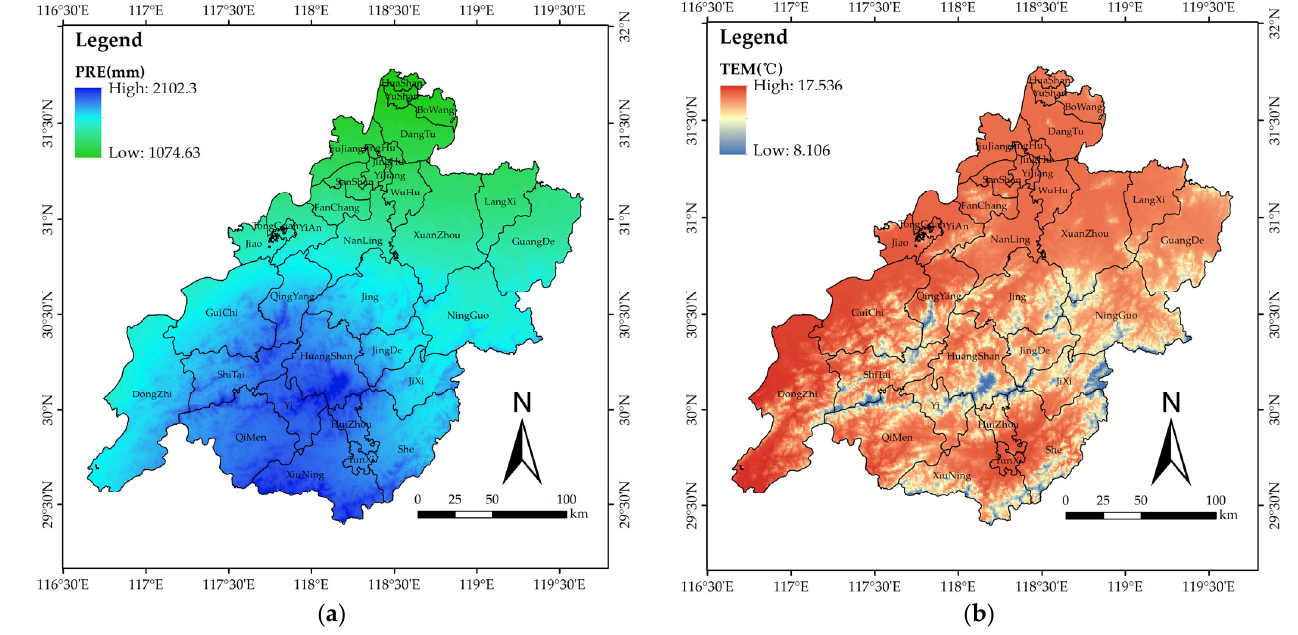
Figure A2. Spatial distribution of the average climate elements in southern Anhui; ( a ) Average annual rainfall in southern Anhui. ( b ) Average temperature in southern Anhui.